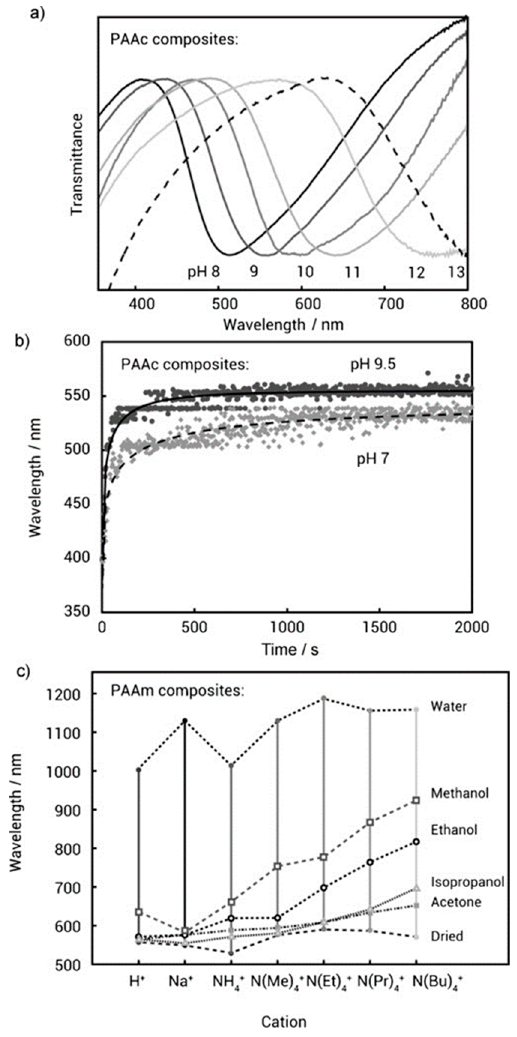
Figure 9. ( a ) Transmission spectra of the nanocomposite (50 wt% cellulose nanocrystal in different basic solutions showing a red shift with increasing pH. ( b ) Time dependence of the reflected colour from a nanocomposite (66 wt% cellulose nanocrystal) immersed in pH 7 and pH 9.5 aqueous solutions. ( c ) The maximum reflected wavelength of a cation-exchanged nanocomposite as a function of cation for dry, aqueous, and organic-solvent-swollen states. PAAm: polyacrylamide, PAAc: poly(acrylic acid). Reprinted with permission from Kelly et al., Angew. Chem. Int. Ed. 2013 , 52 , 8912–8916. Copyright (2013) American Chemical Society.